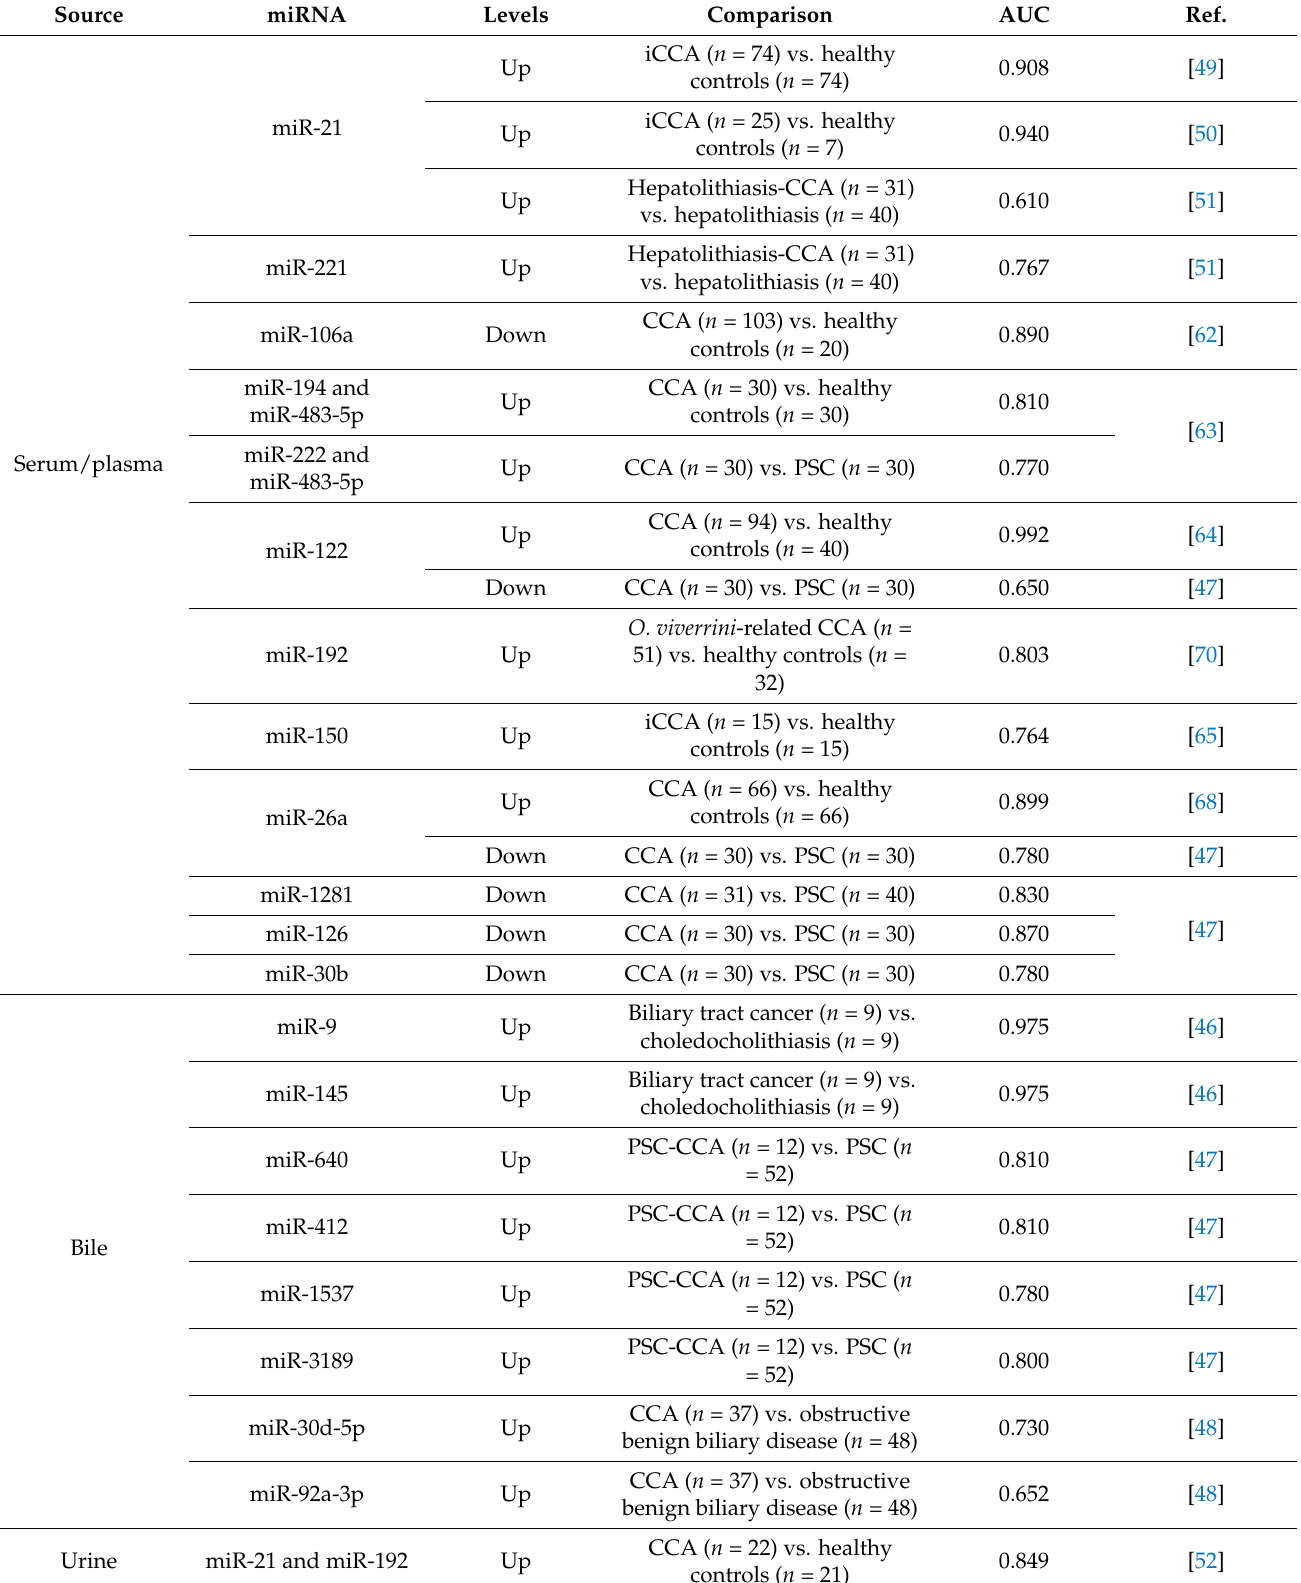
Table 1. Circulating miRNAs with potential diagnostic value for